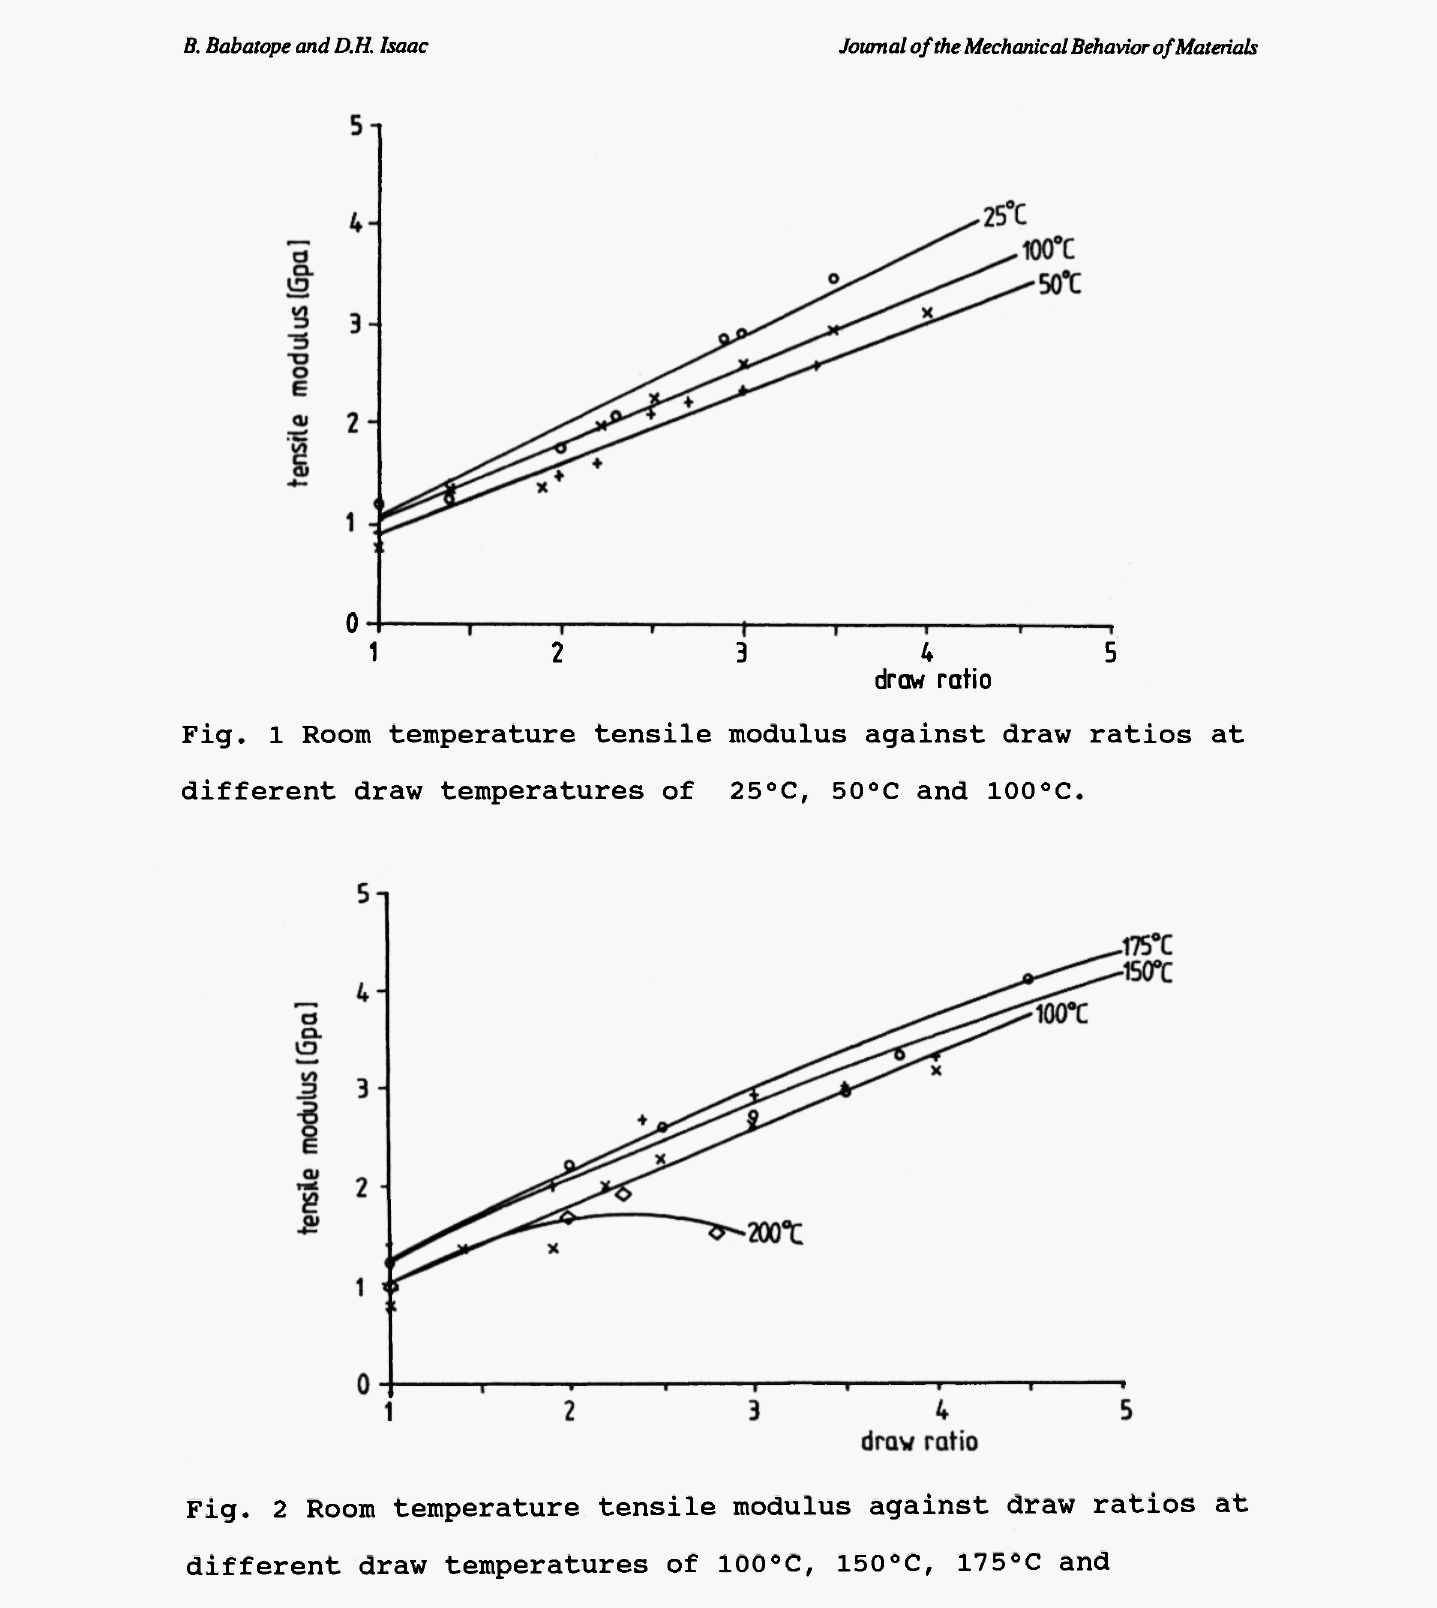
Fig. 2 Room temperature tensile modulus against draw ratios at different draw temperatures of 100°C, 150°C, 175°C and